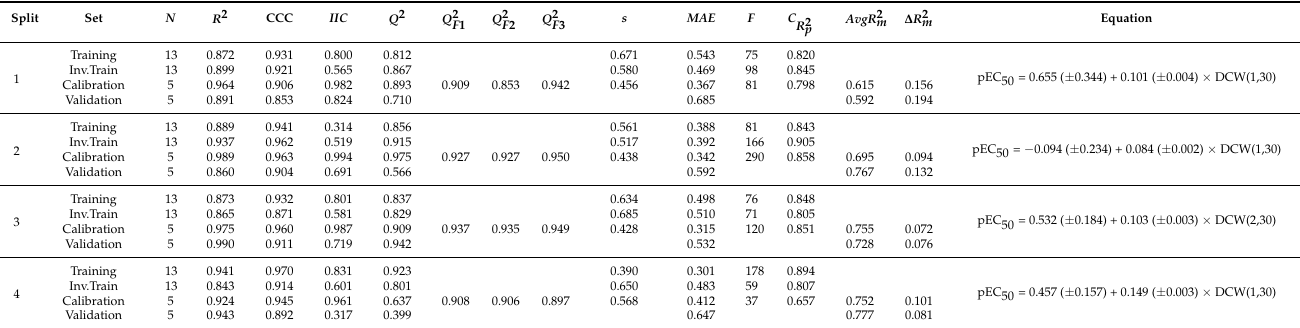
N —number of samples; s —standard error of estimation; F —Fischer ratio.